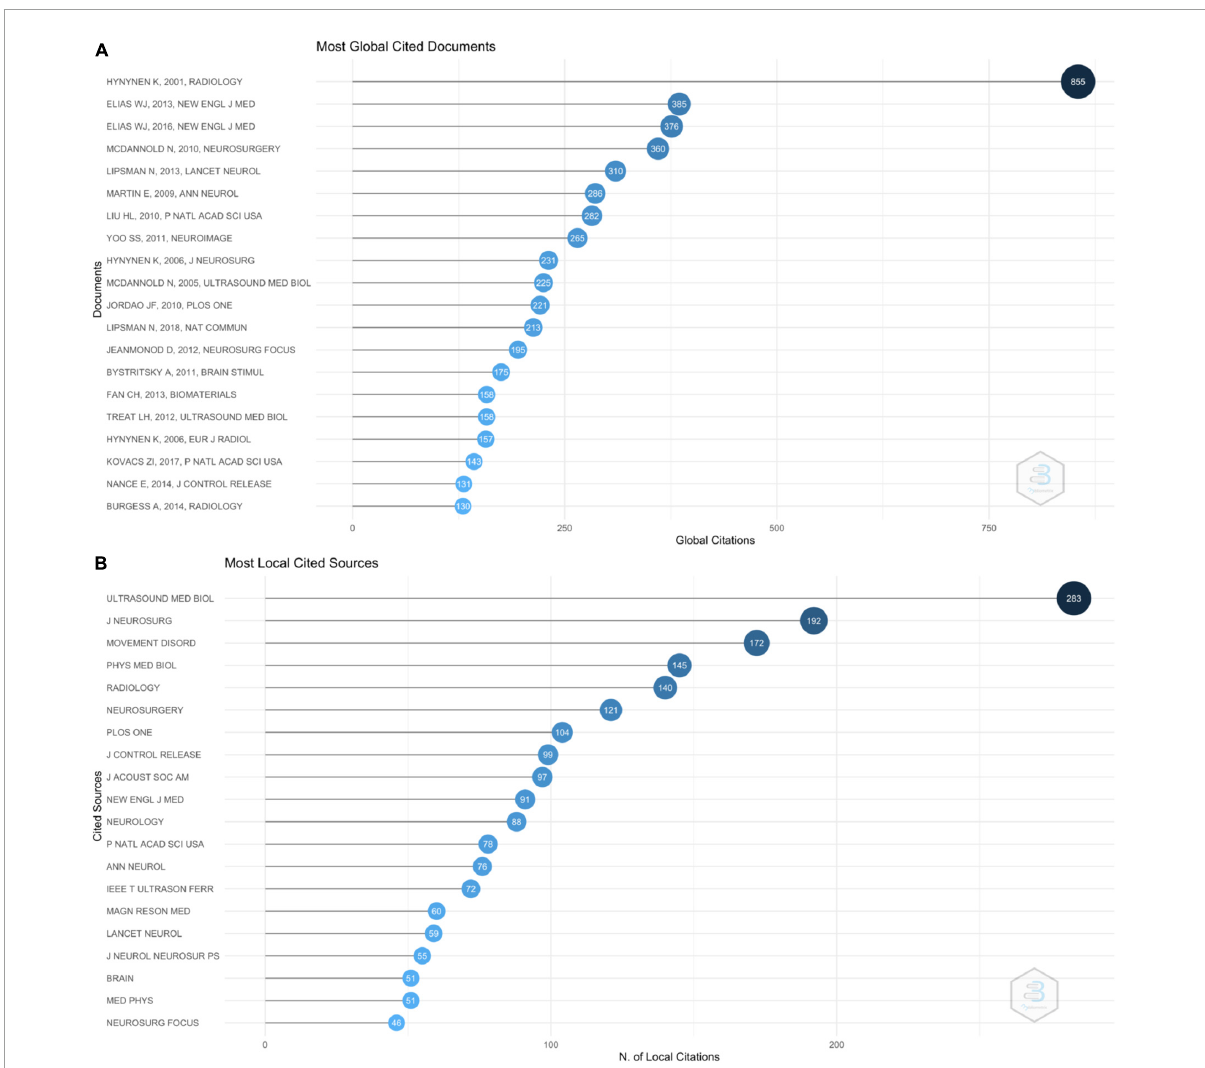
FIGURE6 (A) Graph showing the number of times the top 20 cited articles were cited in all the journals. (B) Graph showing the number of times these top 100 cited articles were cited in these top 100 cited